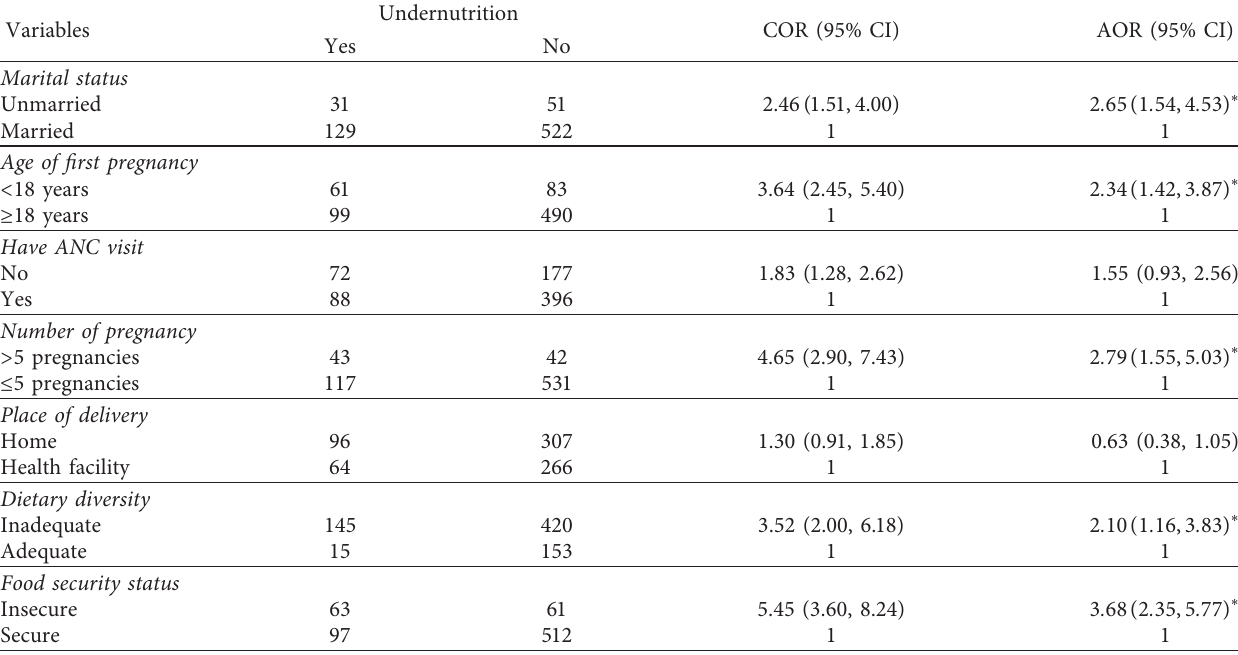
Table 4: Multivariable logistic regression analysis showing factors associated with undernutrition among lactating women who had